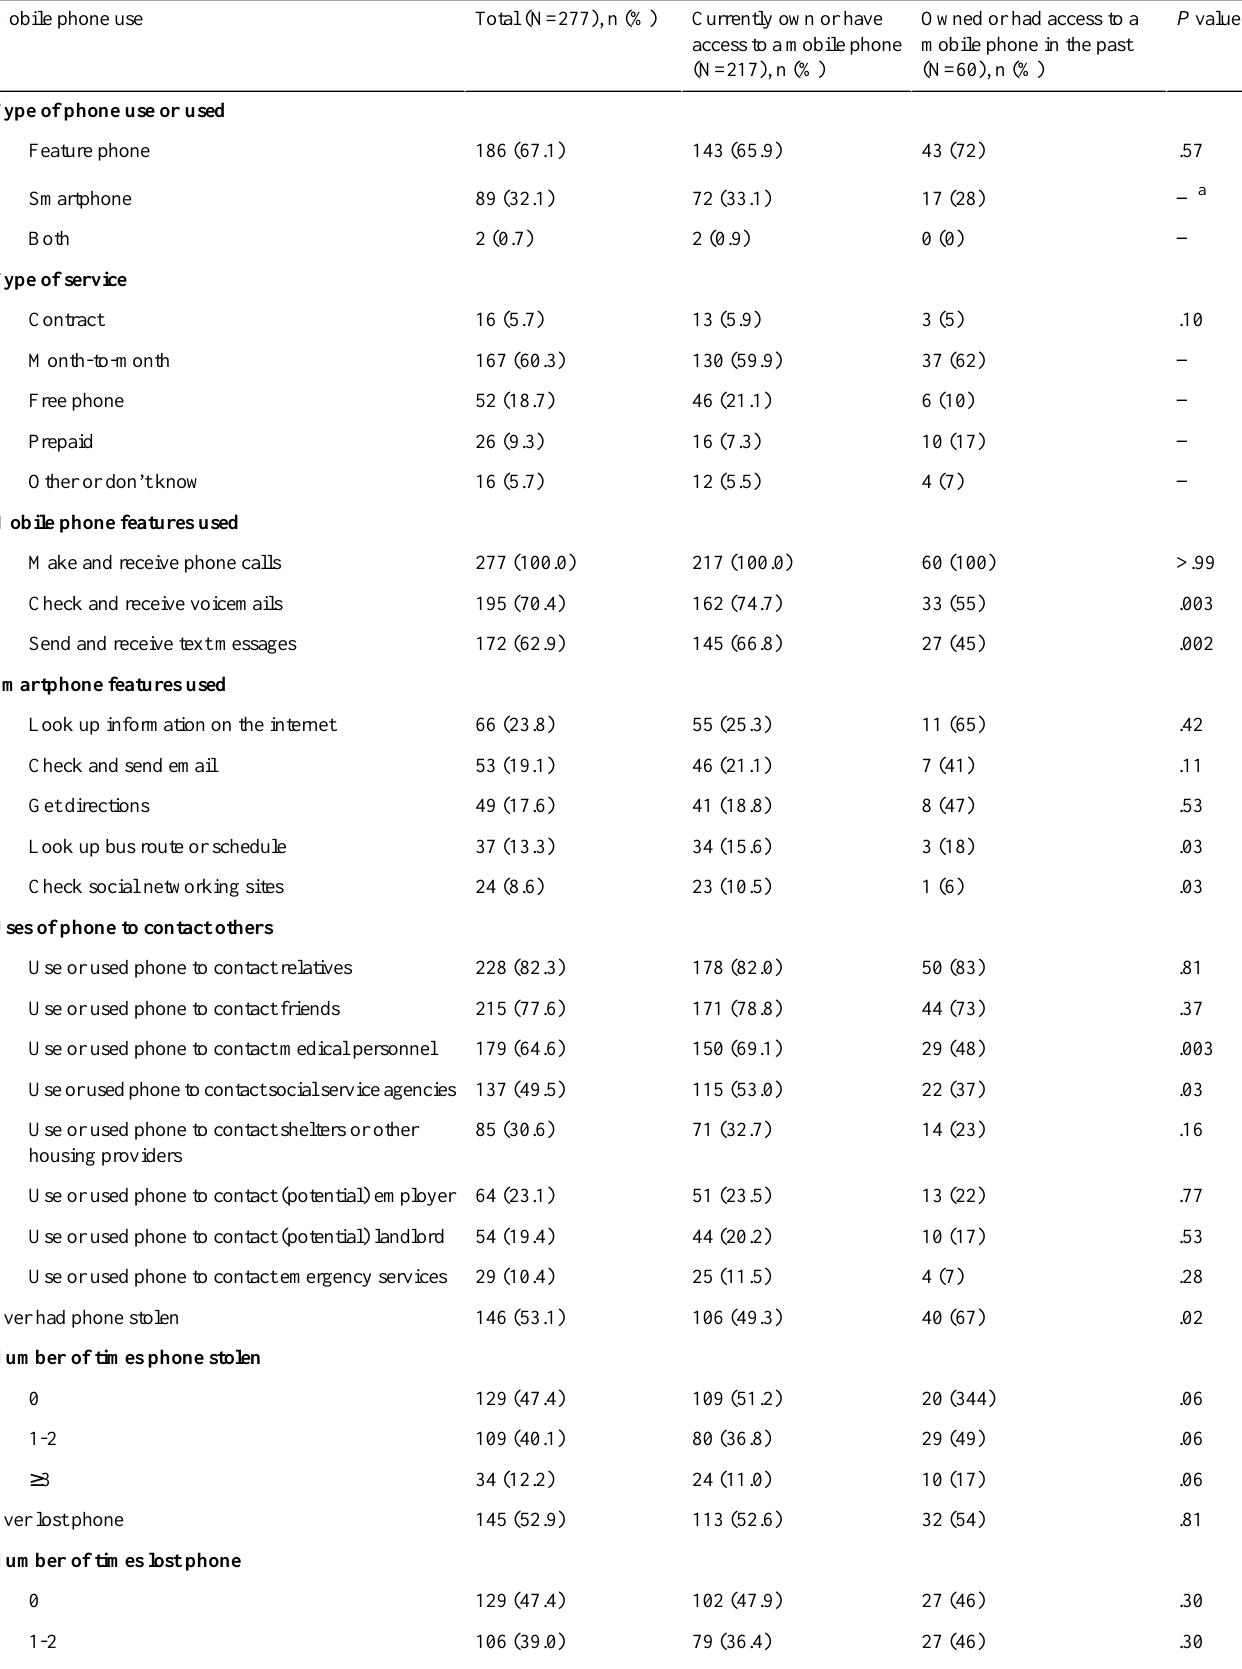
Table 2. Mobile phone